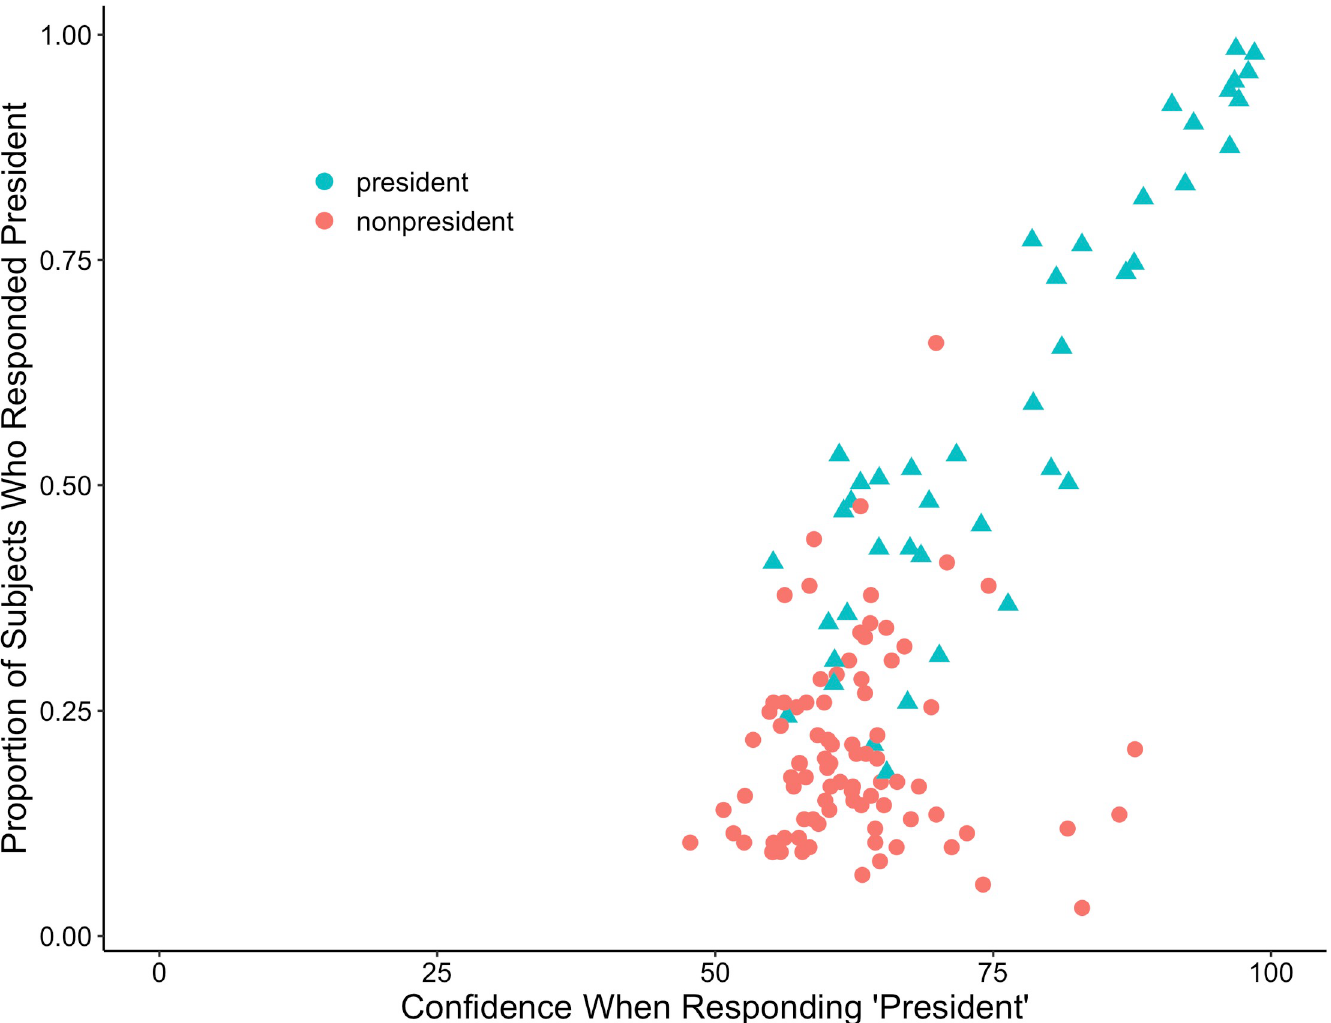
Fig 2. Scatterplot showing the association between the proportion of subjects who identified each image as a president and the mean confidence rating for that choice. Each data point represents a particular portrait, with triangles representing presidents and circles representing nonpresidents. Alexander Hamilton was the nonpresident outlier.